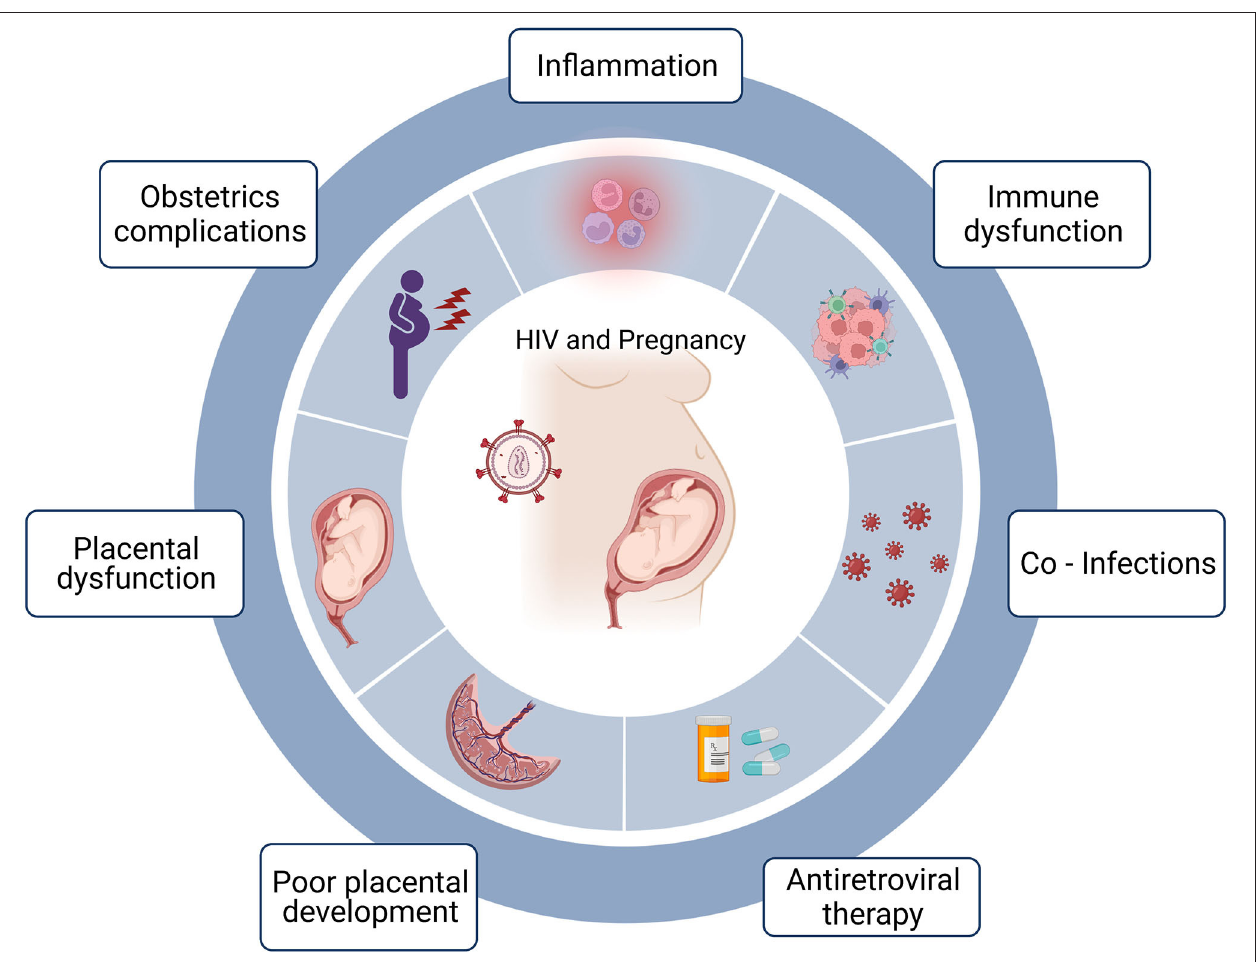
FIGURE 1 | HIV, pregnancy and preterm birth. Maternal HIV infection is associated with preterm birth and the factors that may be linked to preterm birth include acute and chronic inflammation often associated with HIV infection. Immune dysfunction including skewed T cell differentiation, perturbed effector function and altered cellular homeostasis. Co-infections including opportunistic infections due to immunodeficiencies. Certain antiretroviral treatment regimens have been linked to preterm birth and timing of treatment initiation can impact birth outcomes. Poor placental development possibly linked to defective deep placentation. Placental dysfunction including poor perfusion and placental insufficiency and obstetric complications. Created in